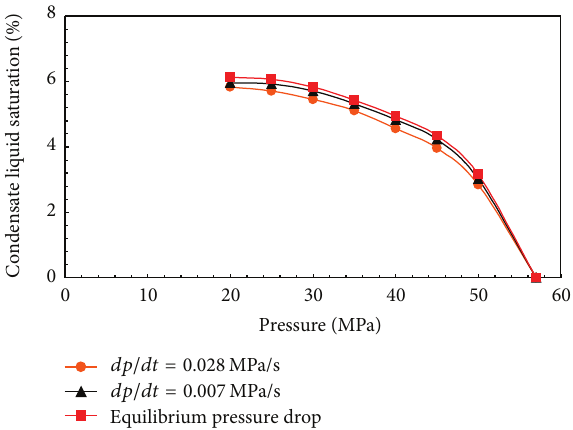
Figure 5: The contrast curve about the calculated retrograde condensate oil saturation in the equilibrium pressure drop by the modified PR EOS, the calculated retrograde condensate oil saturation of different pressure drop rate ( 𝑑𝑝/𝑑𝑡 = 0.007 MPa, 𝑑𝑝/𝑑𝑡 = 0.028 MPa) in the nonequilibrium pressure drop using